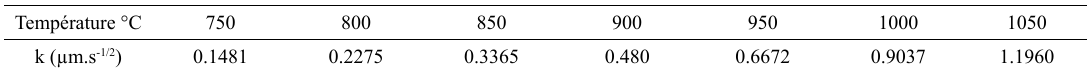
Table 2. Evolution of the absolute value of the growth rate constant according to temperature (τ = 0). Température °C